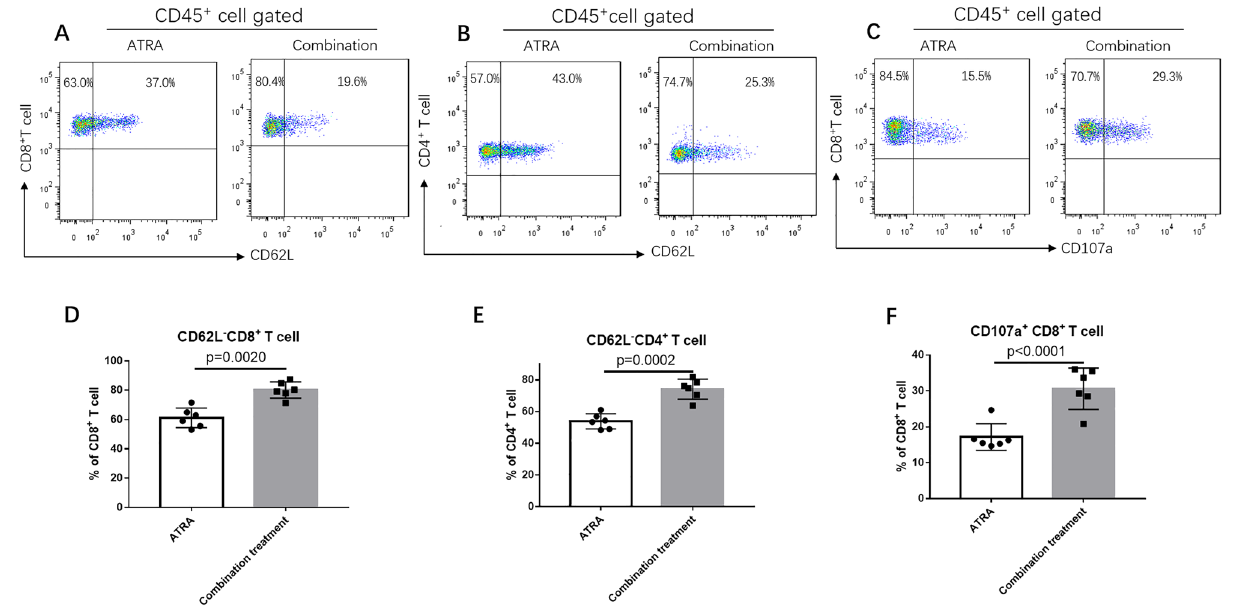
Figure 7. The proportion of T cells with effector functions increased in vivo after combination treatment of ATRA and anti-PD-L1 mAb. Representative flow cytometry dot plots show CD62L − CD8 + T cells ( A ), CD62L - CD4 + T cells ( B ) and CD107a + CD8 + T cells ( C ) in ATRA group and combination treatment group. The comparison of CD62L − CD8 + T cells ( D ), CD62L − CD4 + T cells ( E ), and CD107a + CD8 + T cells ( F ) proportions in two groups are shown. Data are shown as mean ± SD (6 mice/group, 2 repetitions with similar